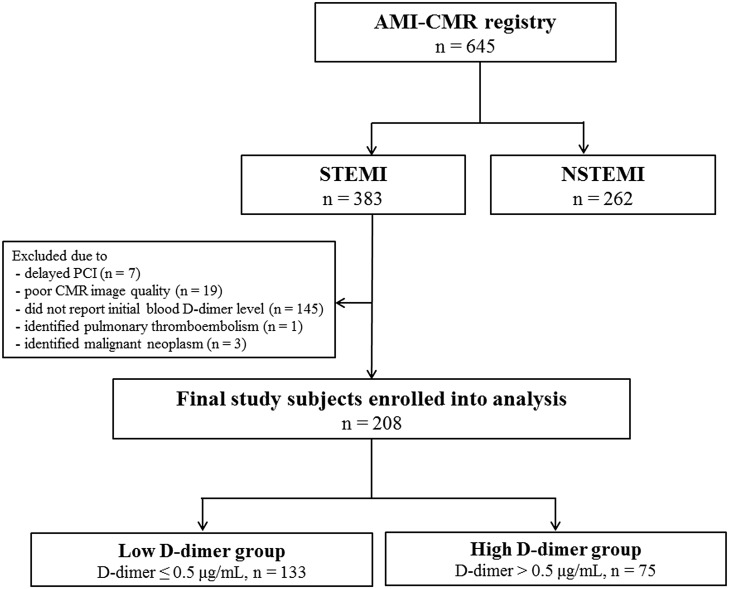
Scheme of Group Distribution.AMI-CMR = acute myocardial infarction–cine magnetic resonance imaging; STEMI = ST-segment elevation myocardial infarction; NSTEMI = non ST-segment elevation myocardial infarction; PCI = percutaneous coronary intervention; CMR = cardiac magnetic resonance imaging.